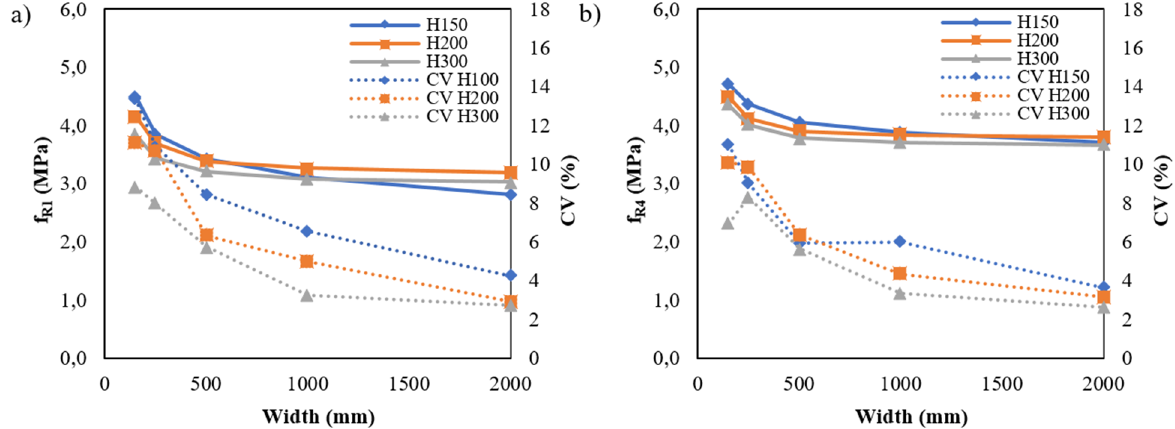
Figure 3 . Average and coefficient of variation assessed for a) f R1 and b) f R4. in specimens with different cross‐sections subjected to